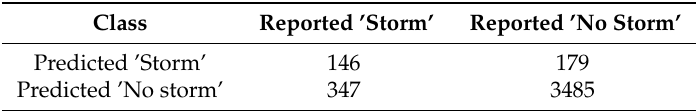
Table 3. Confusion matrix of reported and predicted storm and no storm case. The values show the number of